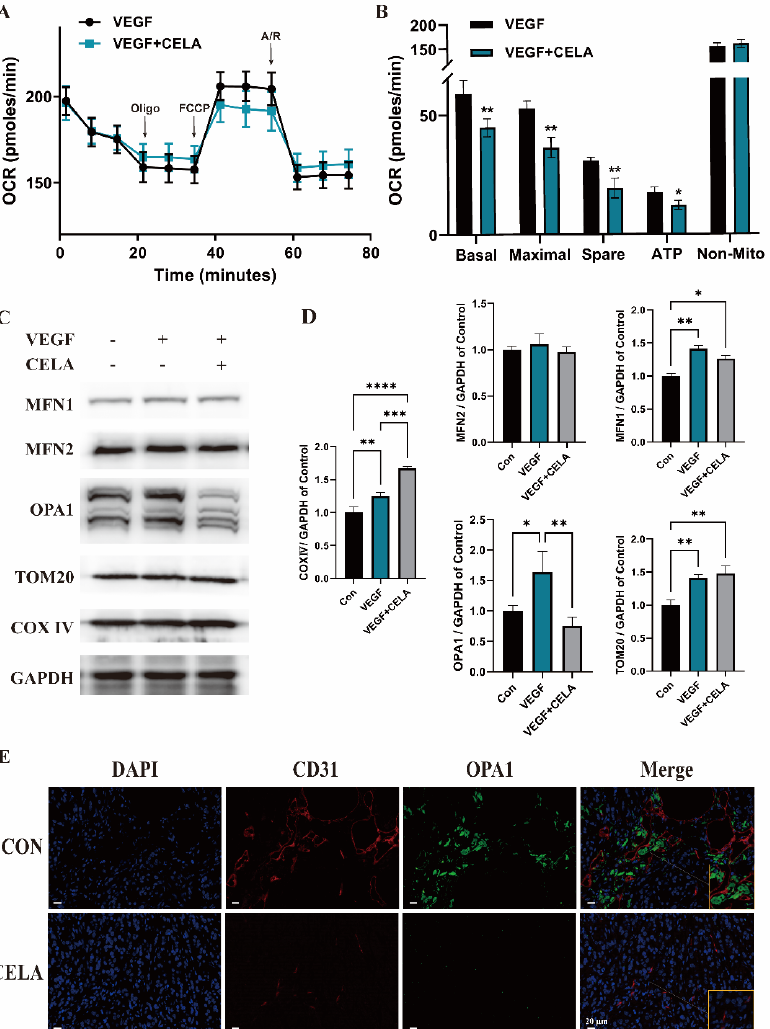
Figure 3. Celastrol affects mitochondrial function and the expression of morphology-related proteins. ( A ) The effects of celastrol on OCR. ( B ) The effects of celastrol on mitochondrial basal respiration, maximal respiration, spare respiratory capacity, and ATP production. ( C , D ) The effects of celastrol on protein levels of MFN1, MFN2, OPA1, TOM20, COX Ⅳ, and GAPDH. ( E ) The expression of CD31 and OPA1 in tumor tissues. * p < 0.05, ** p < 0.01, *** p < 0.001, **** p < 0.0001.